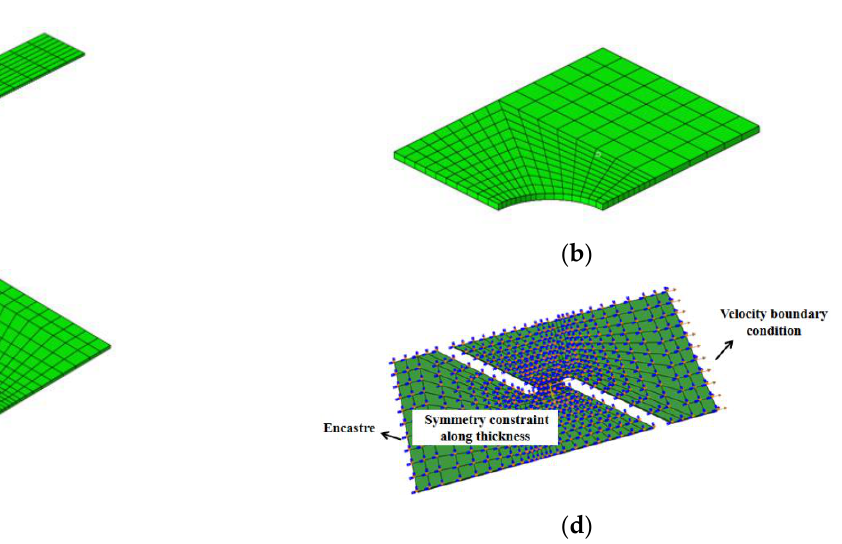
Figure 5. Analysis of element size sensitivity for the notched specimen: ( a ) finite element modelled meshing for the notched specimen; ( b ) comparisons between the experimental and simulated load- stroke curves for the notched specimen; ( c ) local strain evolution along the tension direction for the notched specimens.